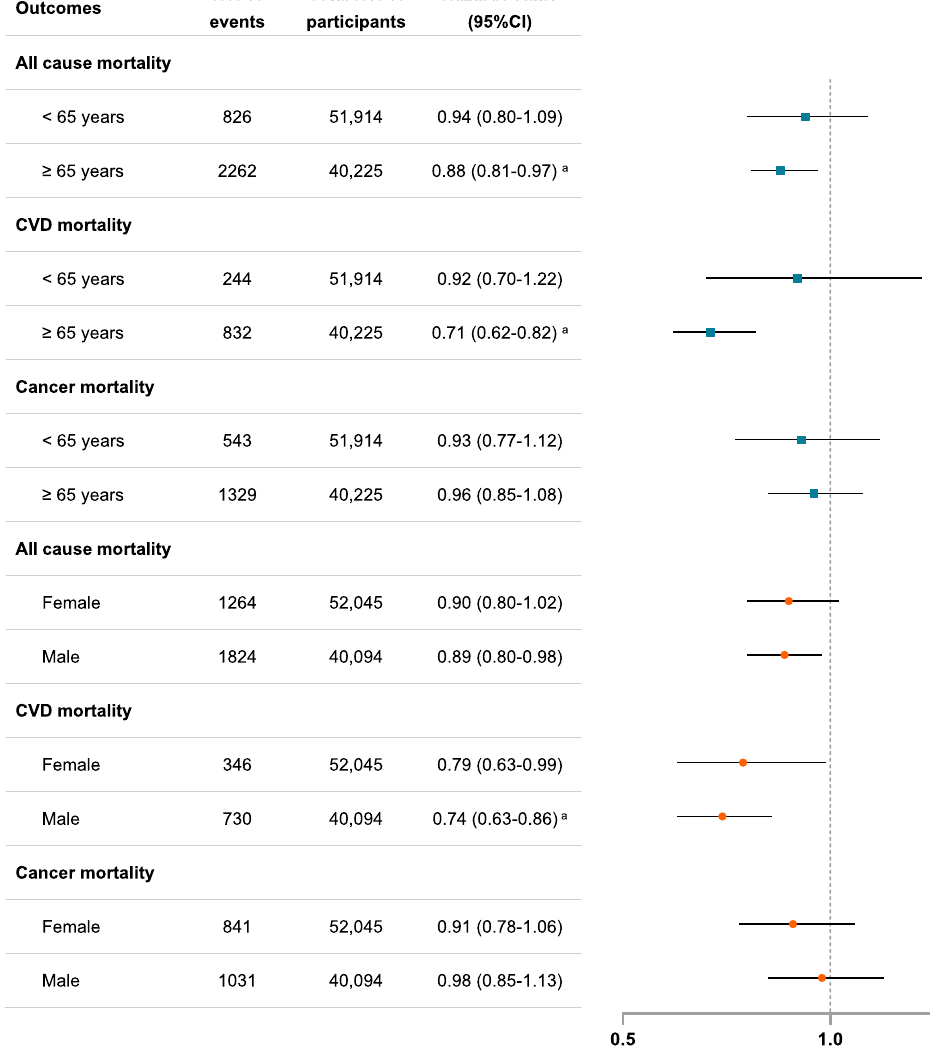
associations with mortality (Table 2), four timing groups were combined into two groups: (1) favorable timing of MVPA (i.e., midday-afternoon or mixed); (2) unfa- vorable(i.e.,morningorevening).Thiscombinationmethodfacilitatedtheanalysis and interpretation of multiplicative and additive interaction effects, which was widely used inprevious studies [Shanetal. BMJ , 2018.;Huang et al. BrJ SportsMed . 2021]. CVD cardiovascular disease, CI con fi dence interval, MVPA moderate to vig- orous physical activity. Error bars represent the 95% CIs for each effect estimate. Source data are provided as a Source Data fi